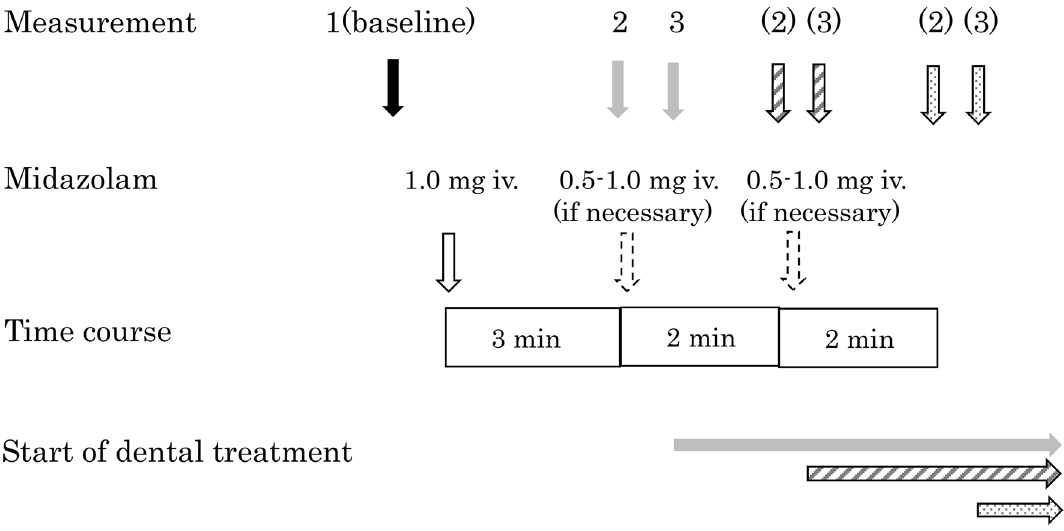
Figure 2. Time course of midazolam administration and